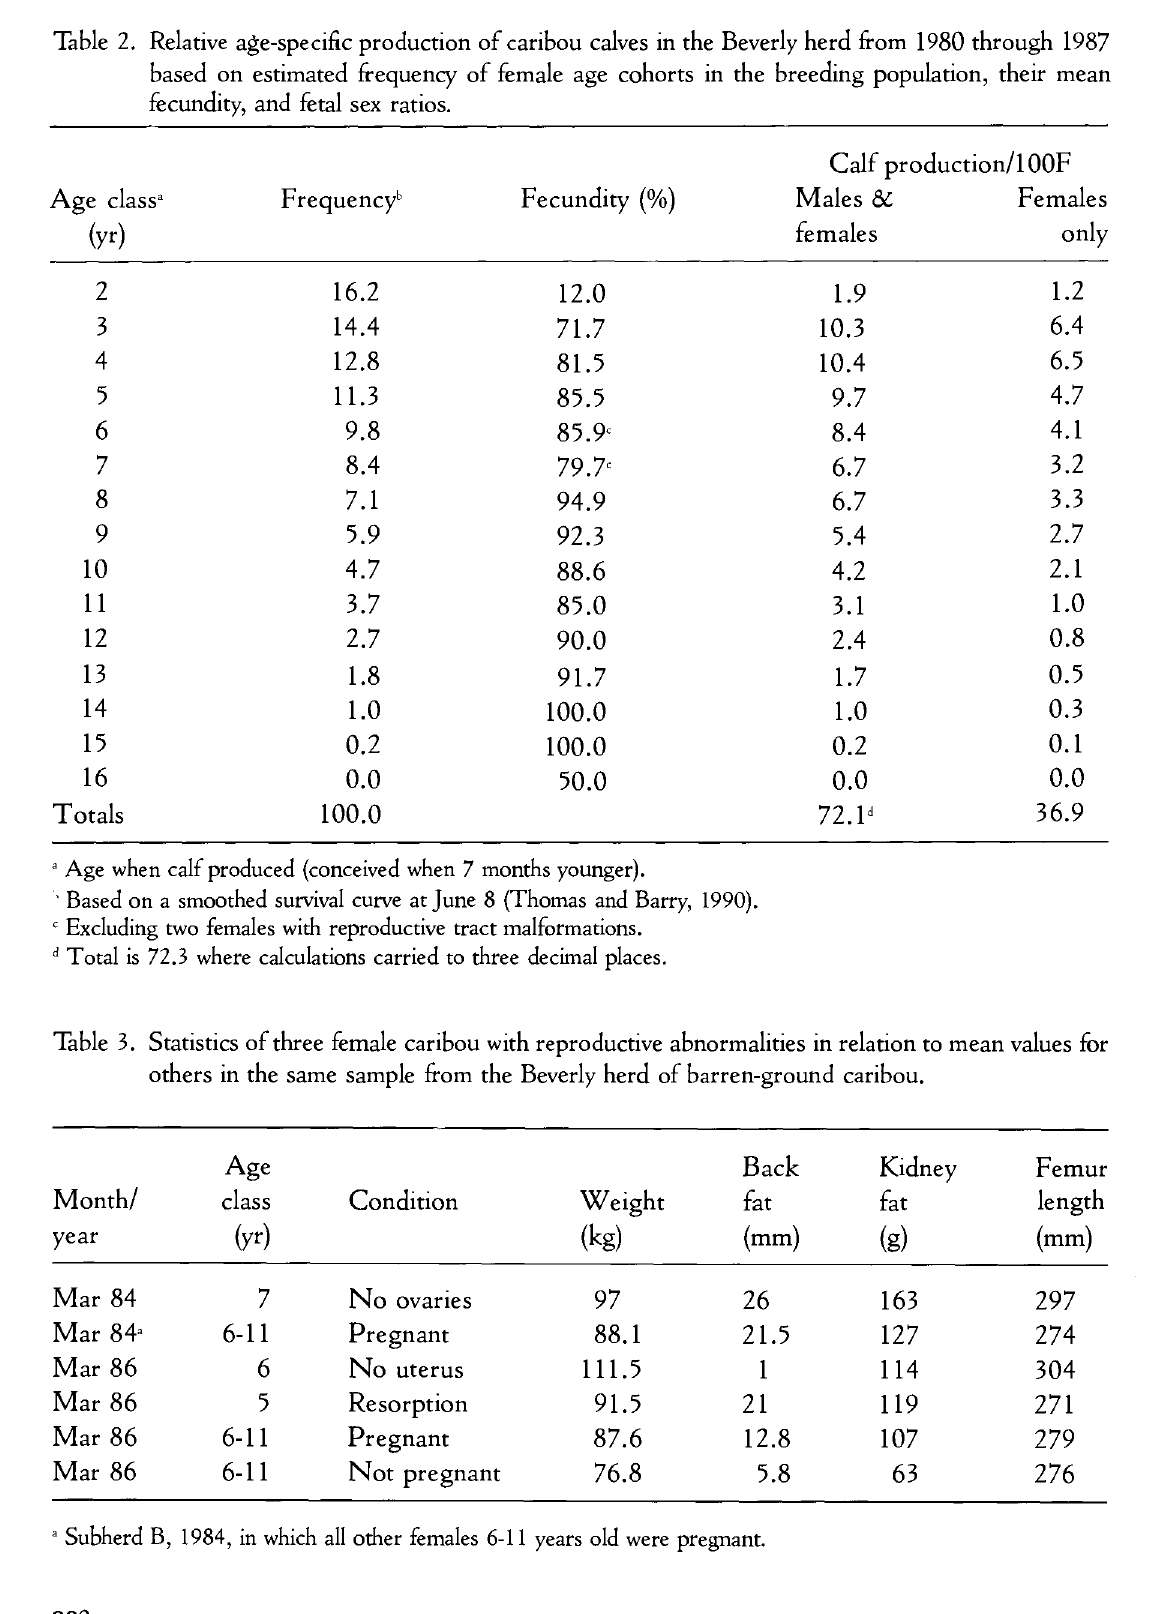
Table 3. Statistics of three female caribou with reproductive abnormalities in relation to : mean values for others in the same sample from the Beverly herd of barren-ground